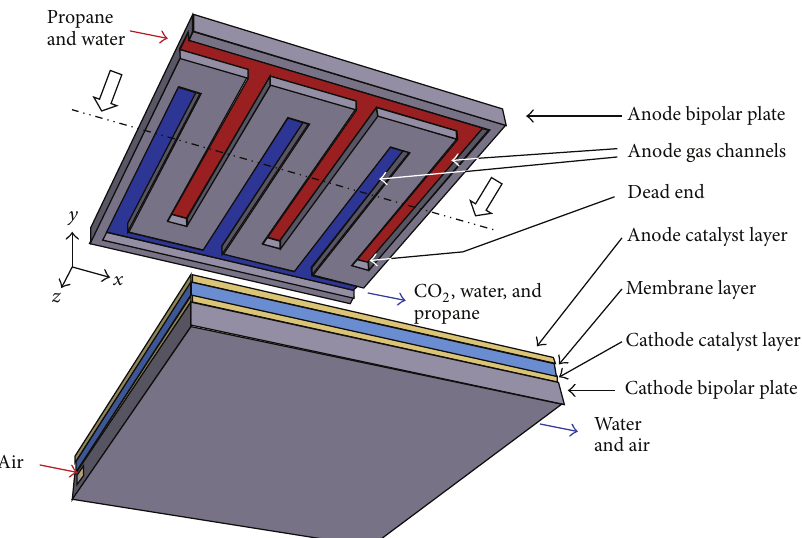
Figure 1: A direct propane fuel cell with interdigitated flow field.